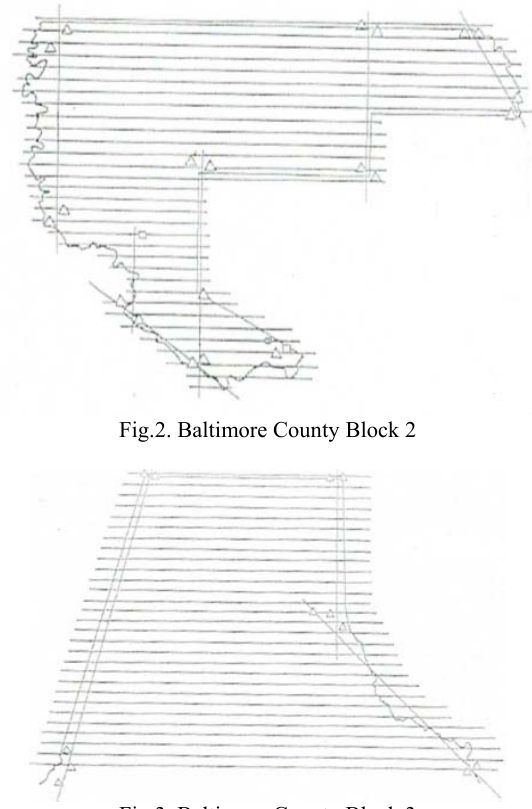
Fig.3. Baltimore County Block